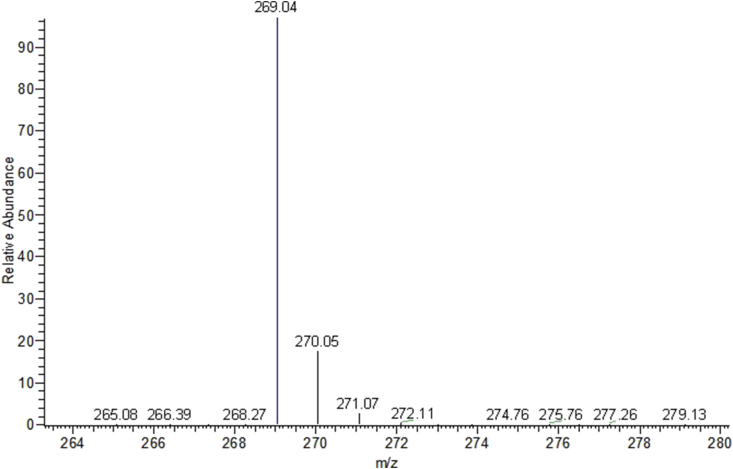
The spectrum of apigenin that was measured with ESI nagative method.